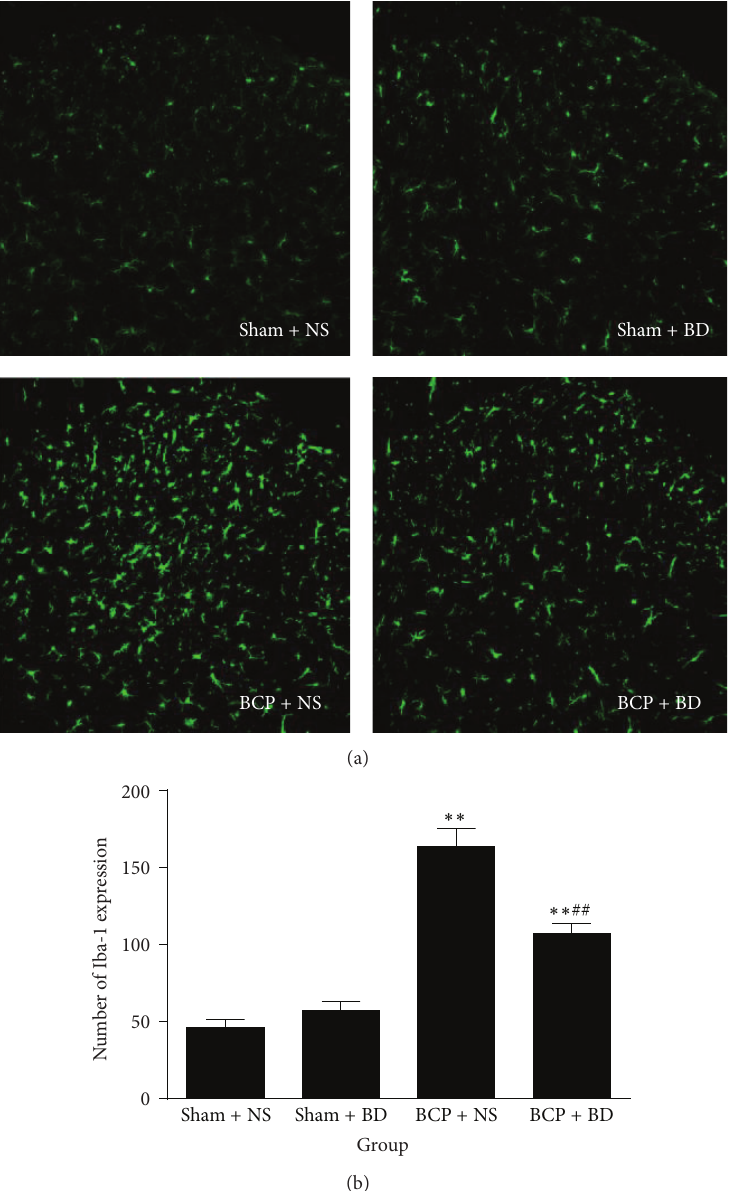
Figure 6: Spinal administration of BD1047 attenuated Iba-1 expression. (a) Immunohistochemistry data revealed that the expression of Iba-1 was significantly higher in BCP rats compared with sham rats in the ipsilateral spinal cord on day 7. Compared with NS-treated BCP group, BD1047-treated BCP group showed a striking decrease in the number of Iba-1 immunoreactive (IR) cells in the ipsilateral spinal cord. (b) Quantification of Iba-1 level in the dorsal horn ( 𝑛 = 4 ). Results are given as means ± SEM. ∗ 𝑃 < 0.05 , ∗∗ 𝑃 < 0.01 versus sham + NS group; # 𝑃 < 0.05 , ## 𝑃 < 0.01 versus BCP + NS group. Magnification: